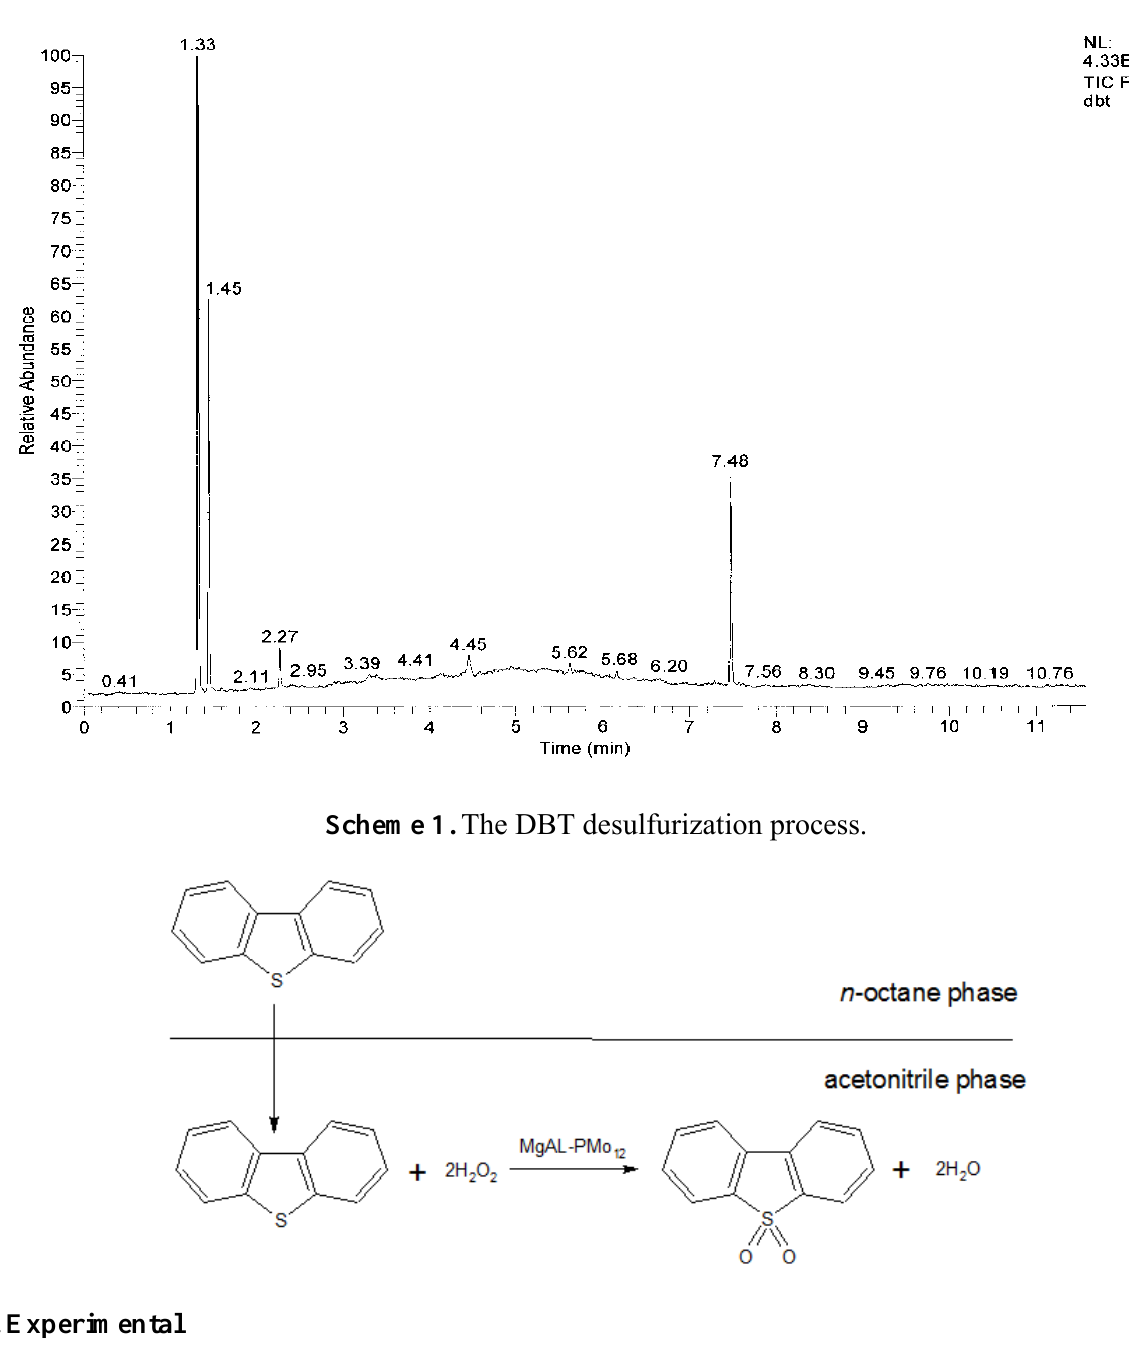
Figure 7. GC-MS analysis for sulfur compounds of acetonitrile after ODS. Retention times: acetonitrile, 1.33 min; n -octane, 1.45 min; DBT, 5.62 min; DBT sulfone, 7.48